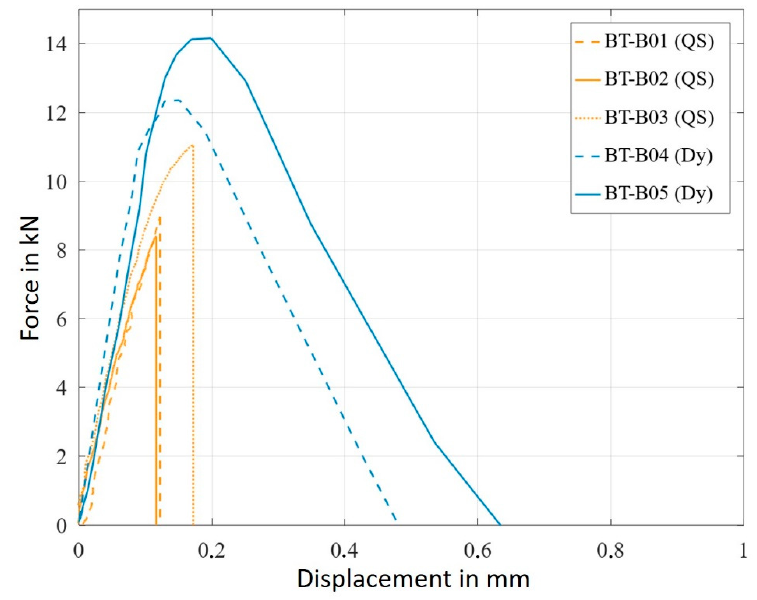
Figure 12. Force–displacement curves of the multi-material bonded joints (QS—quasi-static and Dy—high-rate). Table 2. Results of the multi-material bonded joints (DF—delamination failure).